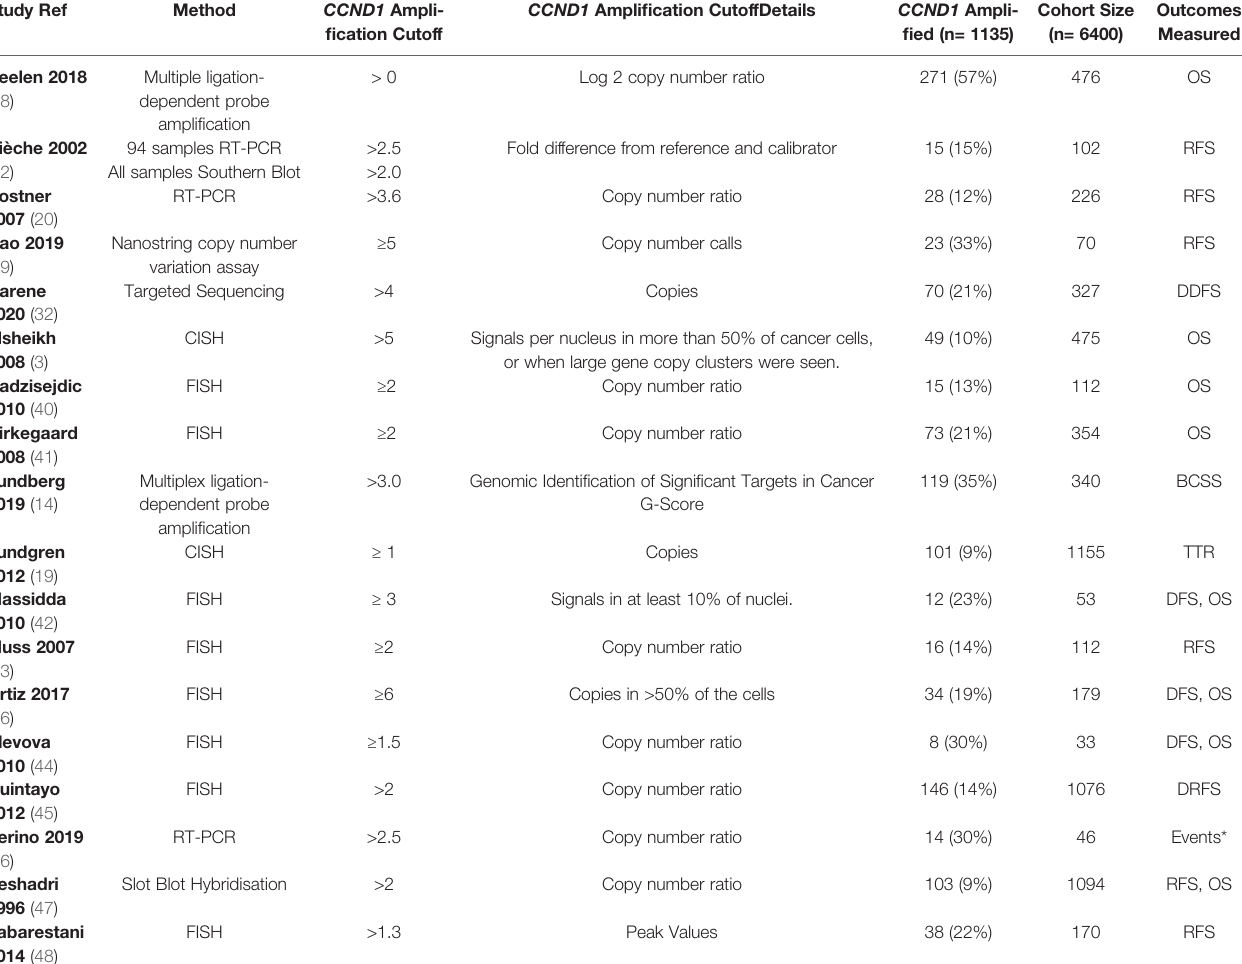
TABLE 2 | Characteristics of Eligible Studies.